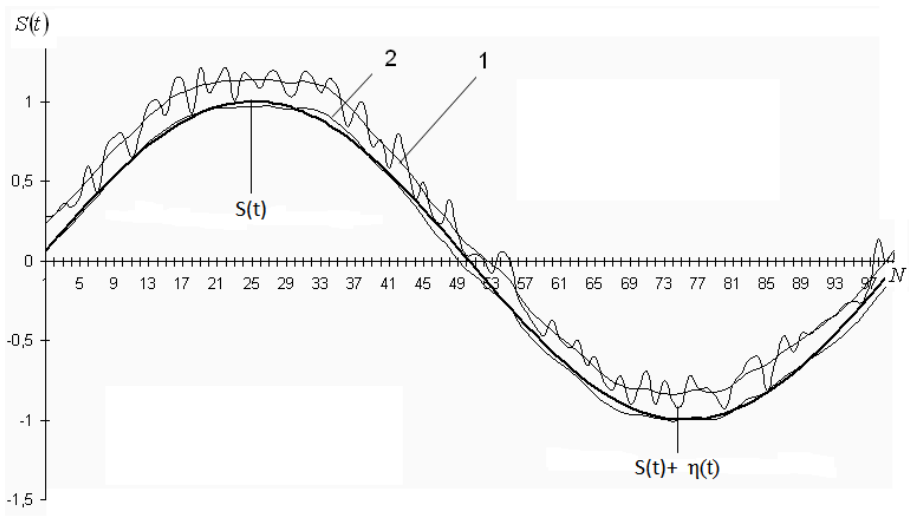
Fig. 7. The processing results of the measurement results with an uncentred additive noise component.